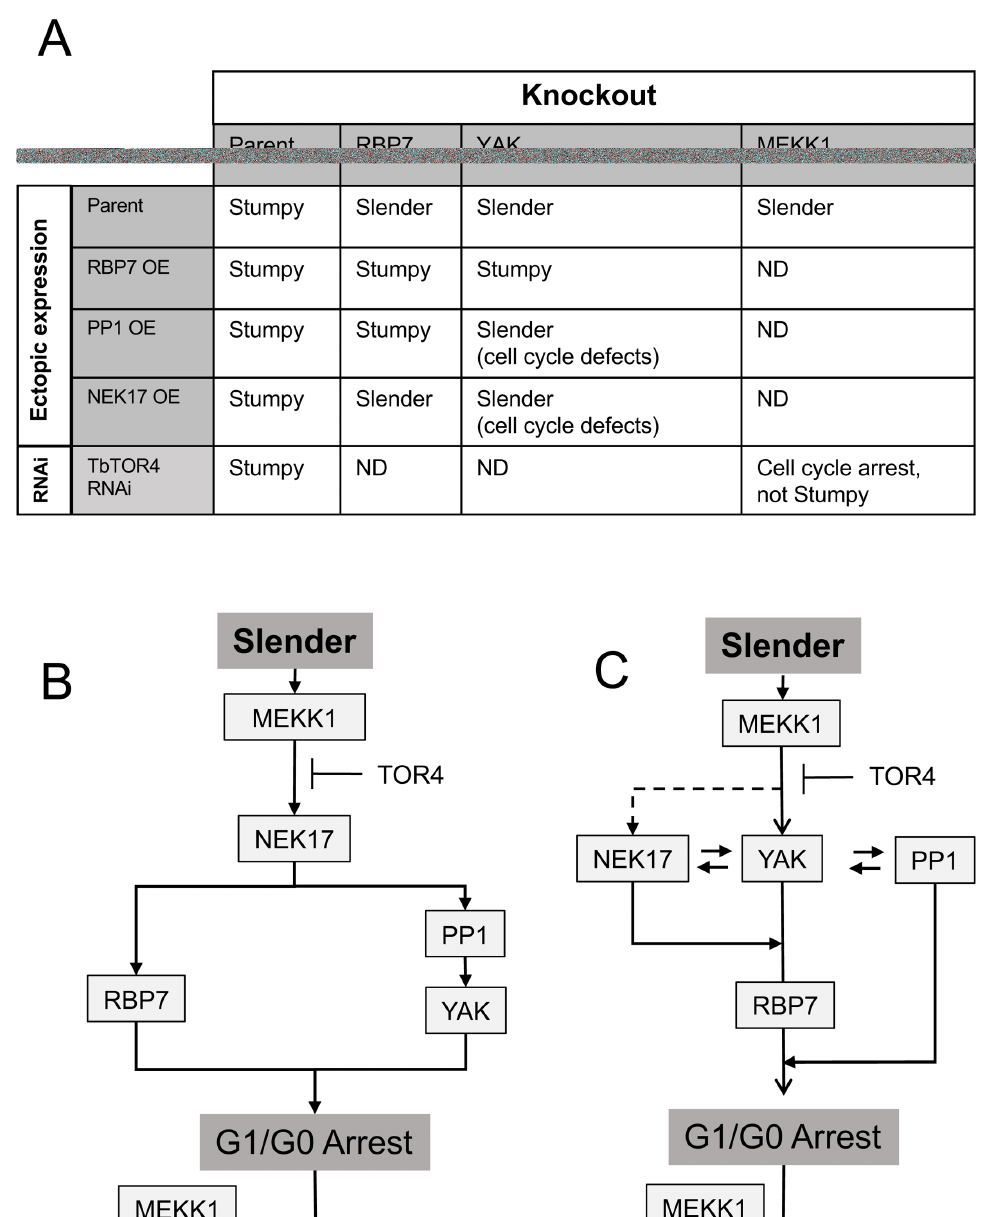
PLOS Pathogens| https://doi.org/10.1371/journal.ppat.1007145 June 25,